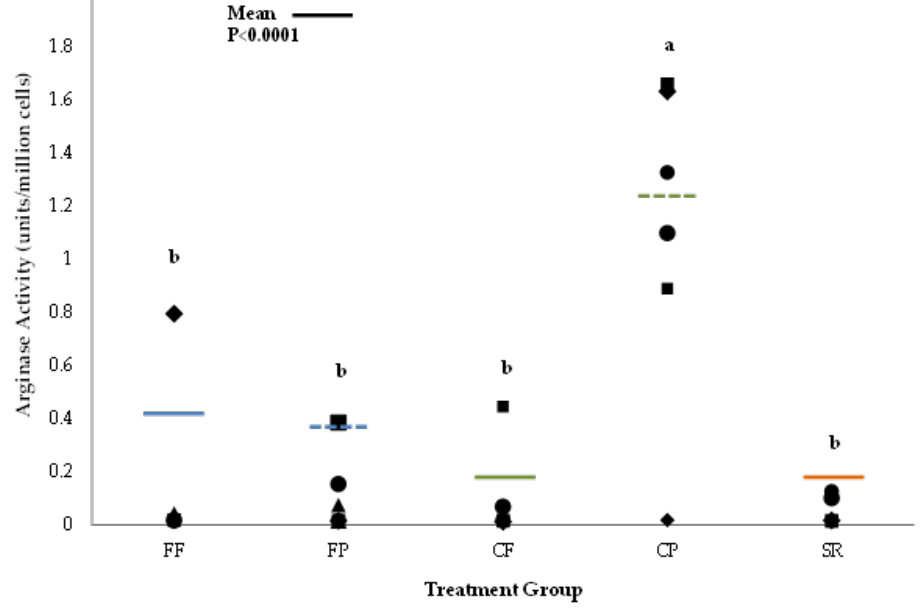
Figure 6. Arginase activity in macrophages isolated from spleens of 21-day-old piglets fed differ- ent Diets. Macrophages isolated from the spleen of piglets in the CP group had significantly higher arginase activity compared to all other groups. Values are mean ± SEM. Different super- scripts (e.g., a vs. b) indicate statistical significance at p ≤ 0.0001. Abbreviations: FF, formula-fed ( n = 8); FP, formula+prebiotic ( n = 9); CF, combination-fed ( n = 6); CP combination-fed+prebiotic ( n = 6); SR, sow-reared ( n = 6).